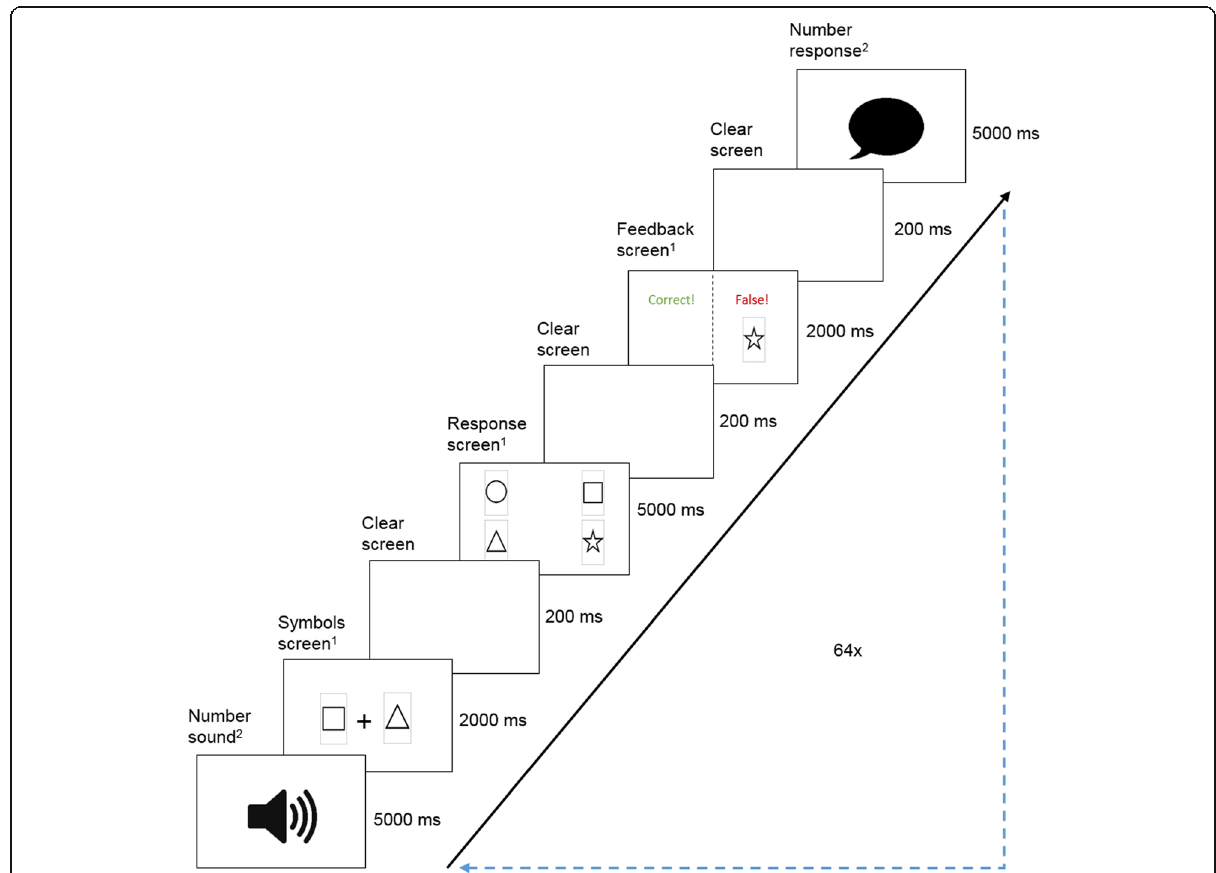
Fig. 2 Schematic outline of the trial procedure in the learning task. Superscript indices indicate affiliation with the primary 1 or secondary 2